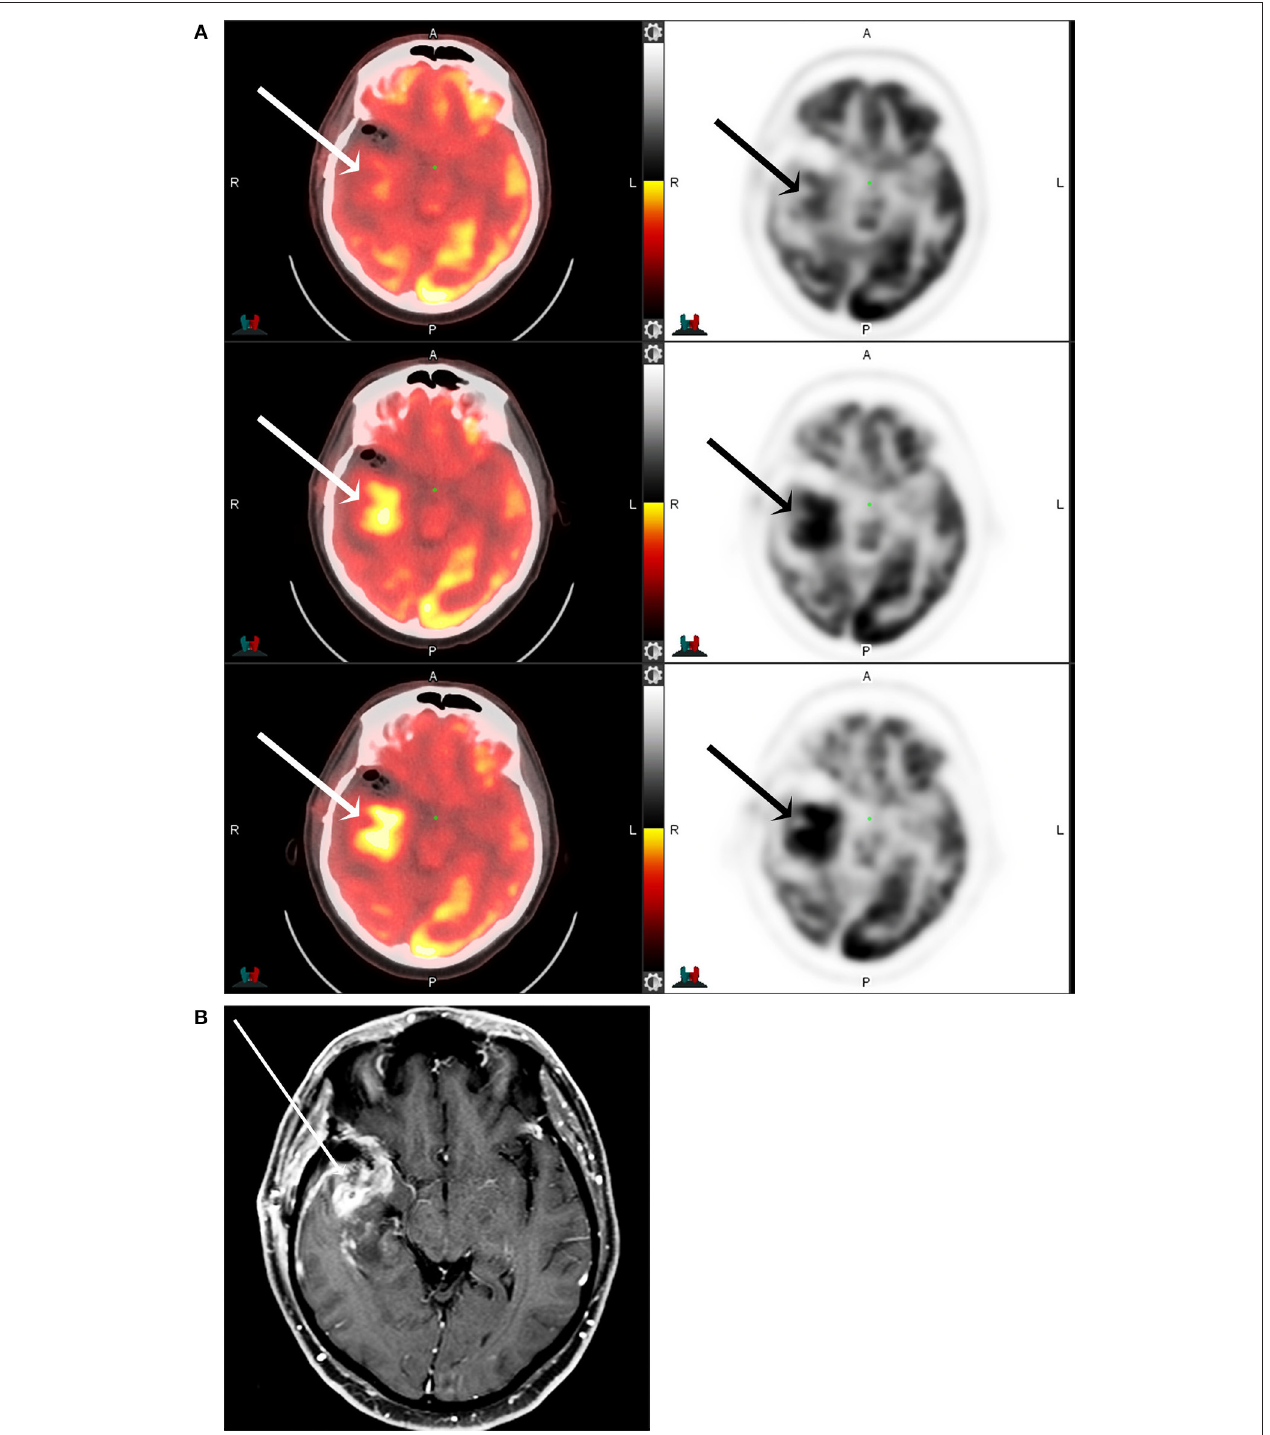
FIGURE 4 | F18 FDG PET CT (A) and T1 post-contrast MRI of the brain (B) of a 53-year-old male with partially resected IDH-mutant, glioblastoma of the right anterior temporal lobe (arrows) at 1-, 5-, and 8-h following F18-FDG injection. The maximum tumor SUV, as well as the tumor to background ratios, are seen to increase with increasing time from the